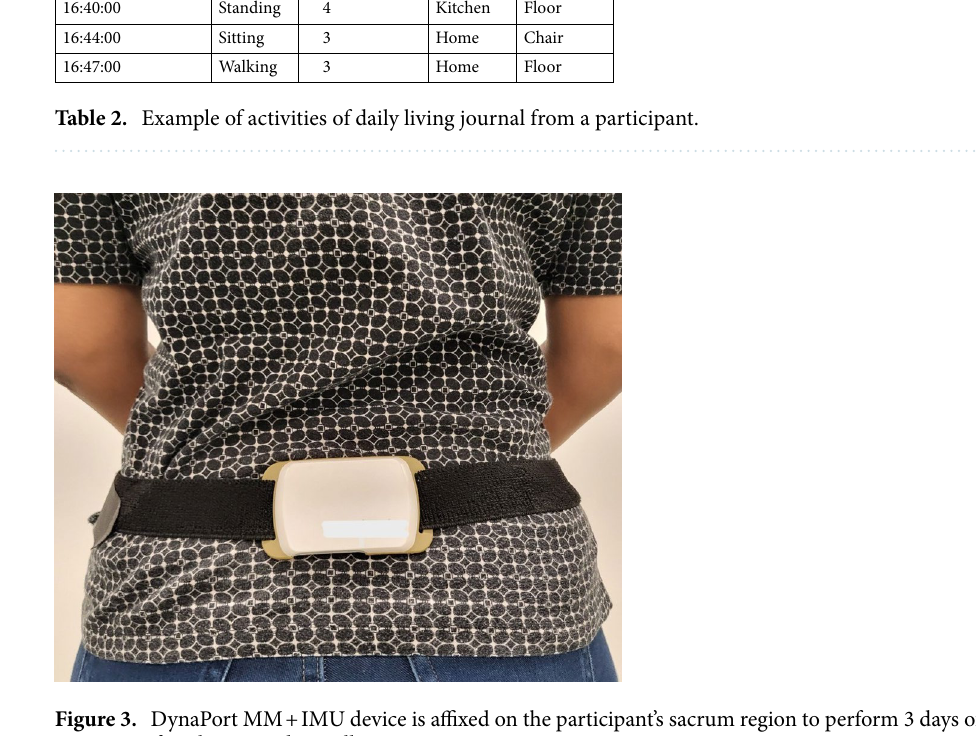
Figure 3. DynaPort MM + IMU device is affixed on the participant’s sacrum region to perform 3 days of Activities of Daily Living data